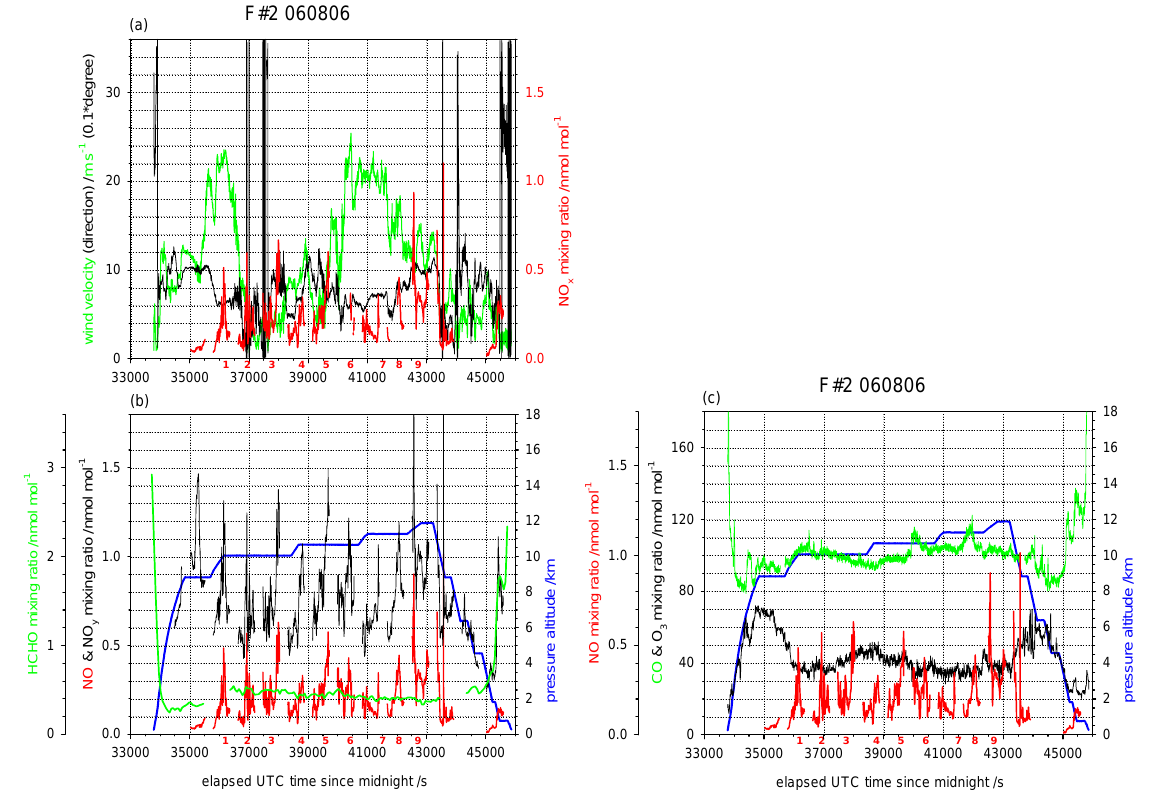
Fig. 3. Time series of NO x , wind velocity and direction in (a) , NO, NO y , HCHO, and pressure altitude in (b) , and NO, CO, O 3 , and pressure altitude in (c) for the Falcon flight on 6 August 2006. Sequences with elevated NO mixing ratios ( ≥ 0 . 3 nmol mol − 1 ) are labelled 1–9 in red.